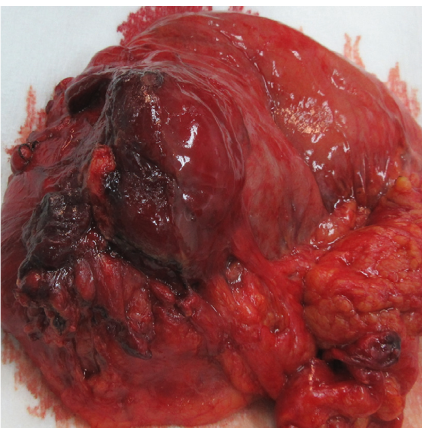
Figure 2: Resected gastric mass after